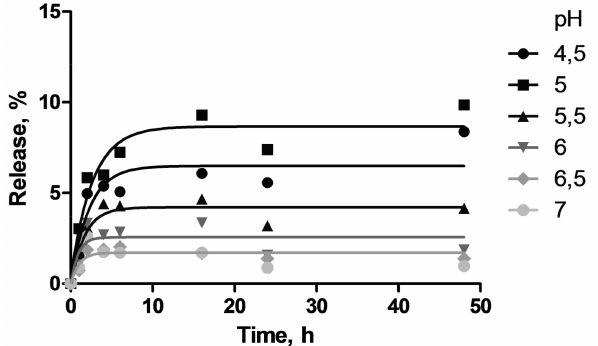
Figure 6. Kinetic profiles of the release of the oligonucleotide from the hydrogel 6G3 @10% Glc at a different